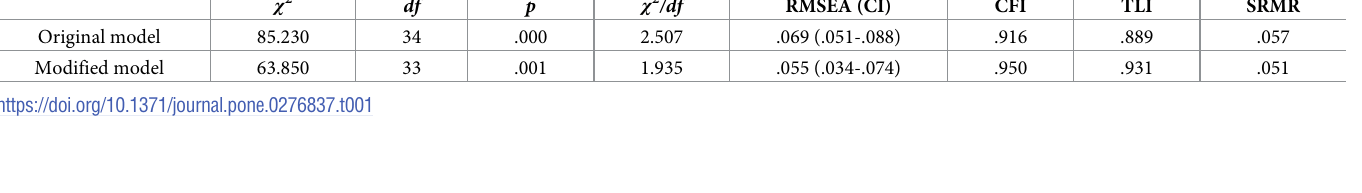
Table 1. Goodness-of-fit indices for the two-factor model of the Bengali PSS-10. χ